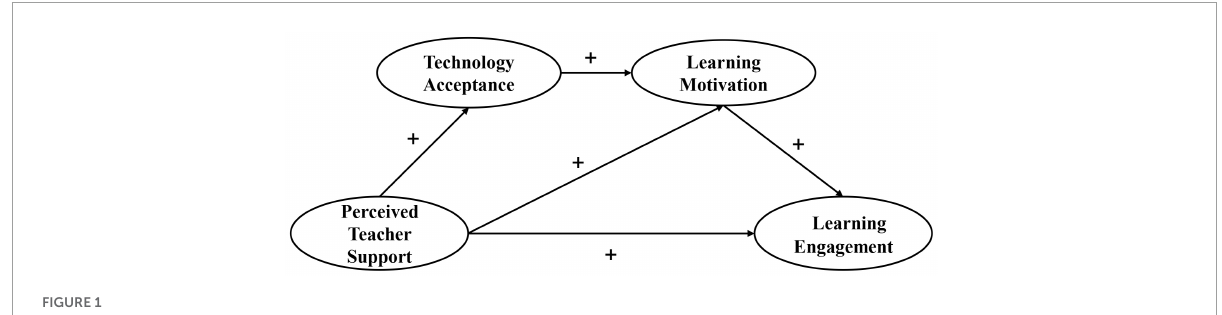
FIGURE1 Hypothesized research model.